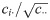
The average product correction (APC) and entropy bias correction (EntC) term correlate strongly.A For protein 1c9oA in the PSICOV data set the correction defined by the APC correlates well with the correction determined by our entropy bias correction strategy when learning a Markov random field (MRF) model with persistent contrastive divergence (PCD). B Also the factors appearing in the APC and EntC corrections, ci·/c·· and αsi., correlate well. C,D The Pearson correlation is similarly large when the MRF model is learnt from synthetic alignments generated with CCMgen using binary tree topologies (C) or using star tree topologies (D), both in the example of protein 1c9oA shown here and also across all 150 proteins in the Pfam dataset (S4 Fig).